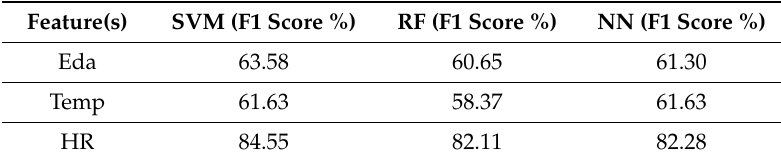
Table 2. F1-scores of classifiers trained on single modality feature